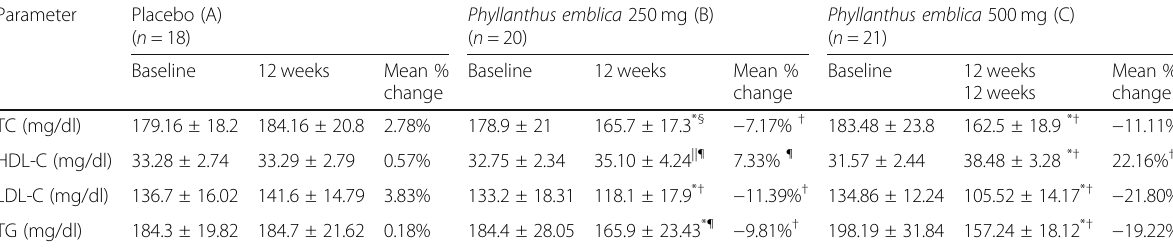
Table 4 Effect of Placebo , Phyllanthus emblica 250 mg and Phyllanthus emblica 500 mg on lipid profile